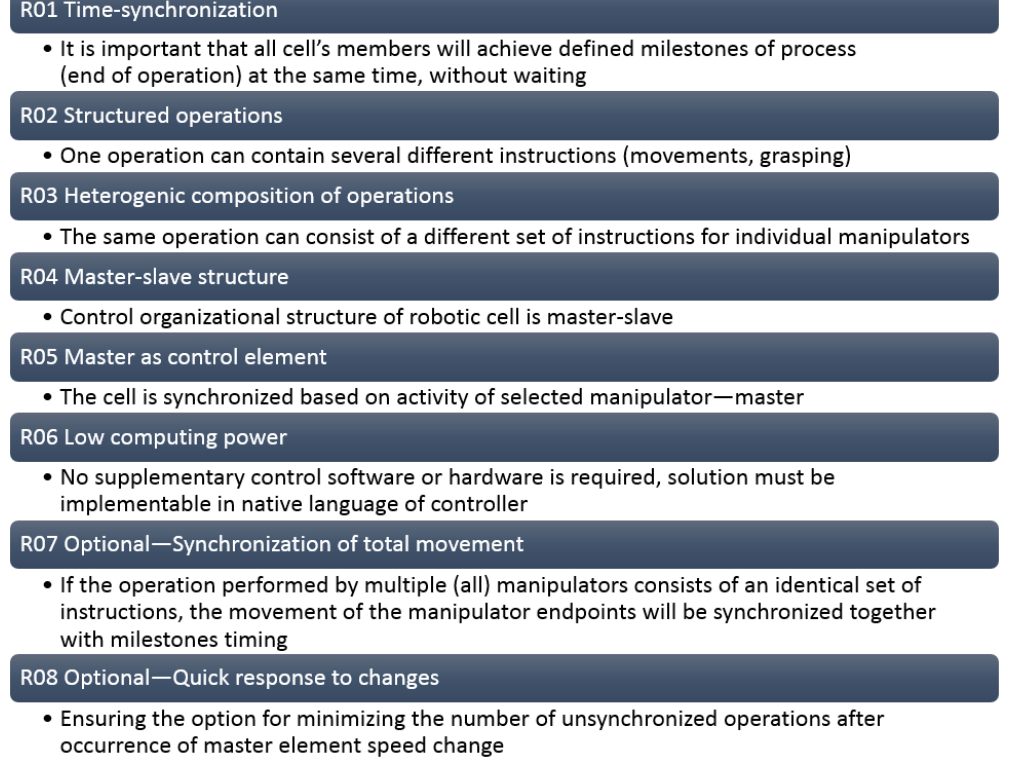
Figure 1. Requirements for algorithm design.